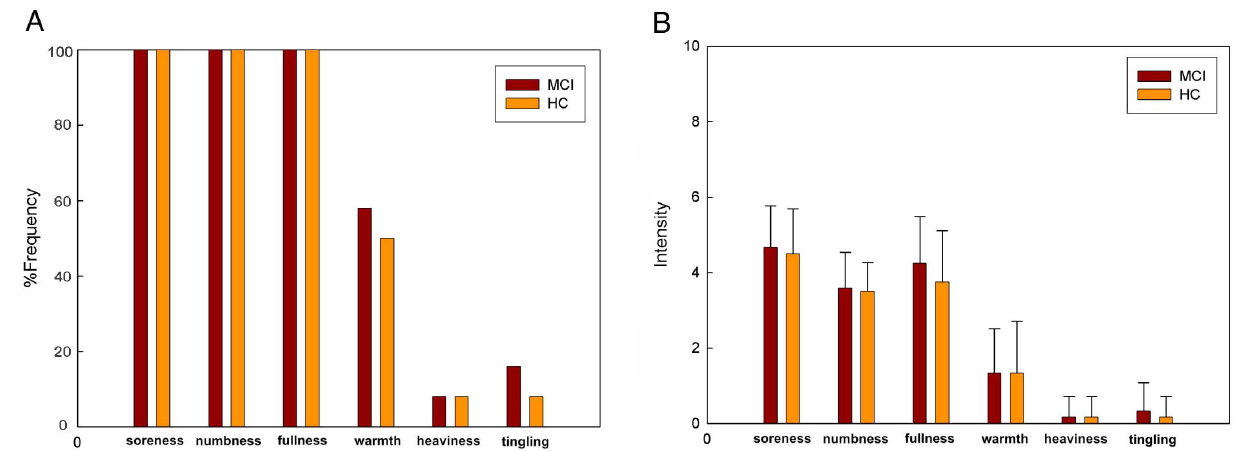
Figure 2. Averaged psychophysical response (N = 12) in MCI and HC groups. A: The percentage of subjects who reported having experienced the given sensation (at least one subject experienced the six sensations listed). B: The intensity of reported sensations measured by an